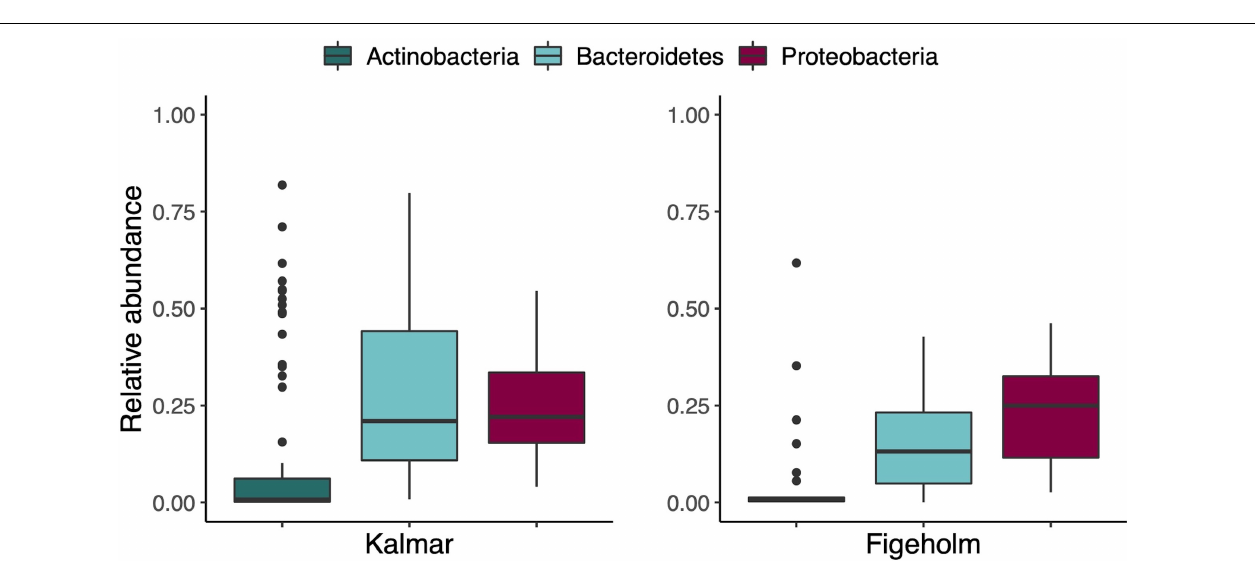
FIGURE 3 | Hierarchical levels of fish skin microbiome richness representing host individuals, populations, and regional scales. Each dot represents an individual, black line represents the mean richness among individuals within Kalmar and Figeholm population, respectively. Red dashed line represents the total numbers of 16S rRNA gene ASVs observed within each population. Red solid line represents the total number of ASVs found among all samples (5,778 ASVs).